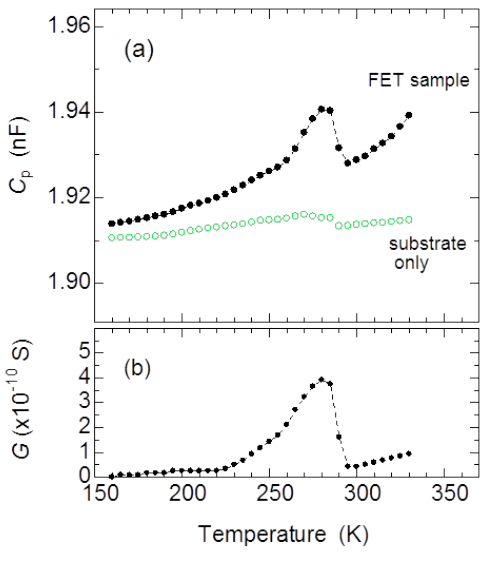
Figure 2. Temperature dependence of the capacitance ( C in (BEDT-TTF)(TCNQ) FET structure. C 4